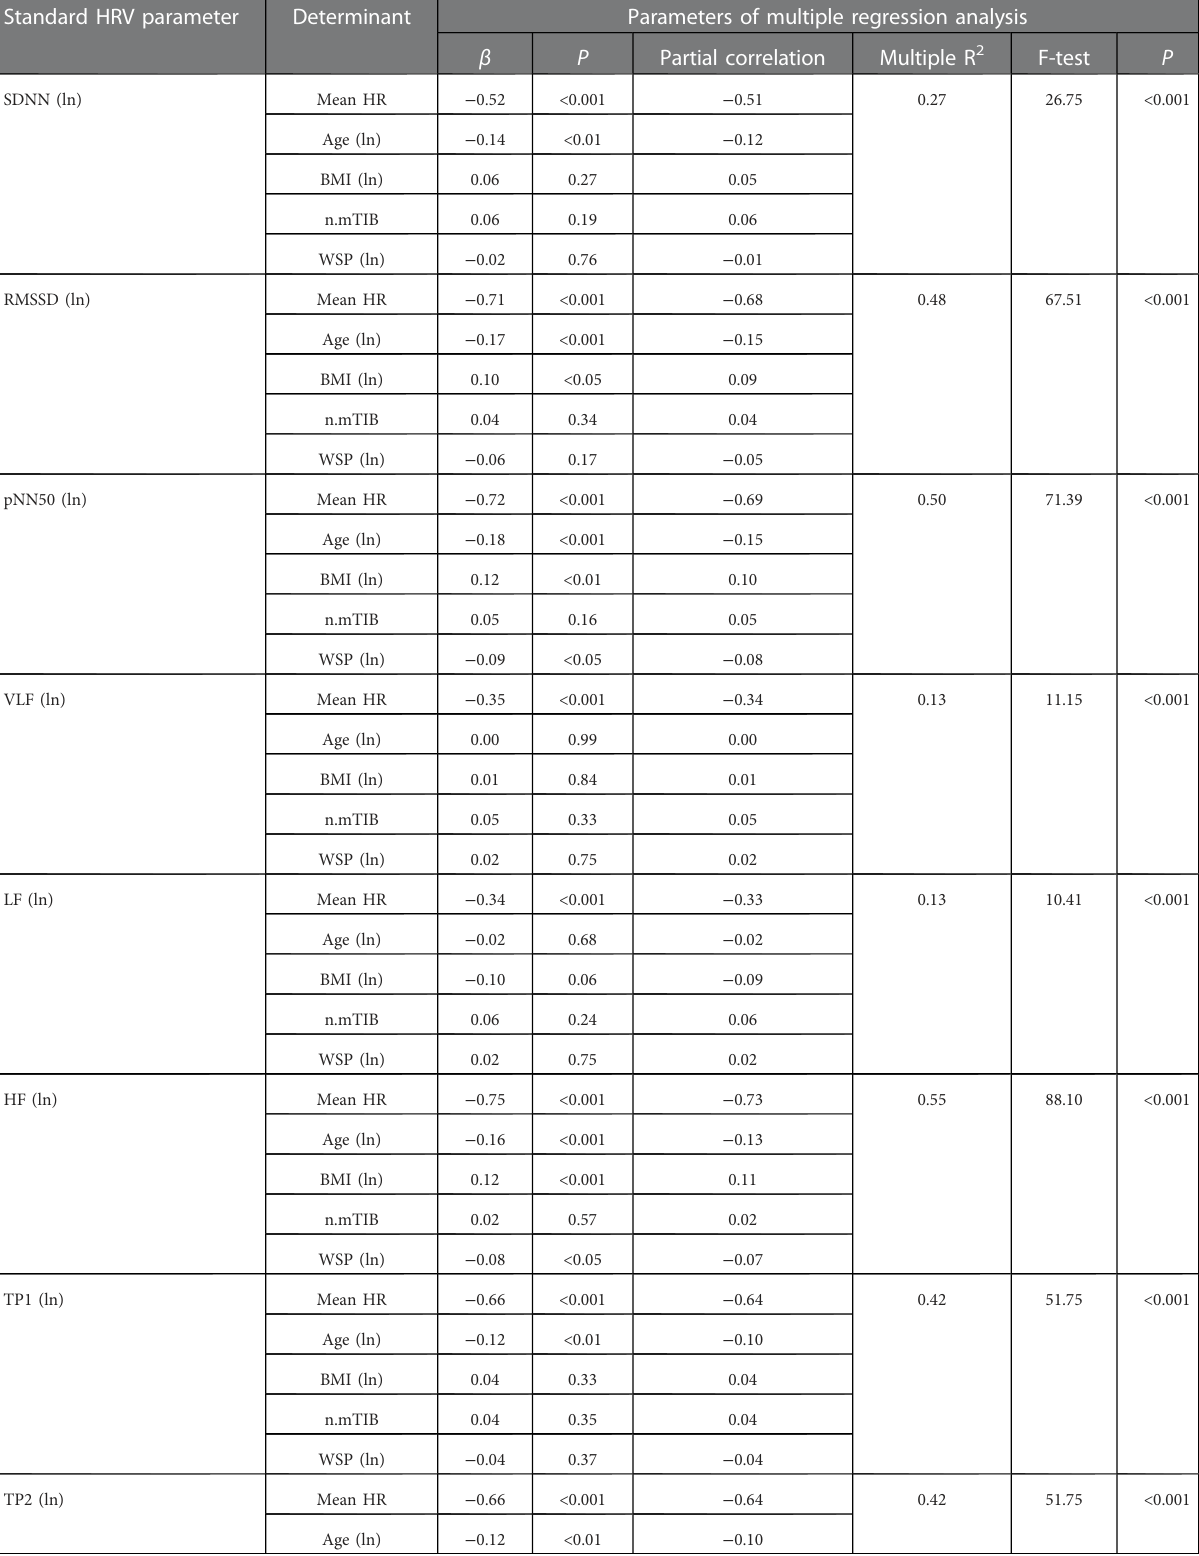
TABLE 3 Determinants of standard time and frequency-domain HRV parameters calculated with fast-Fourier